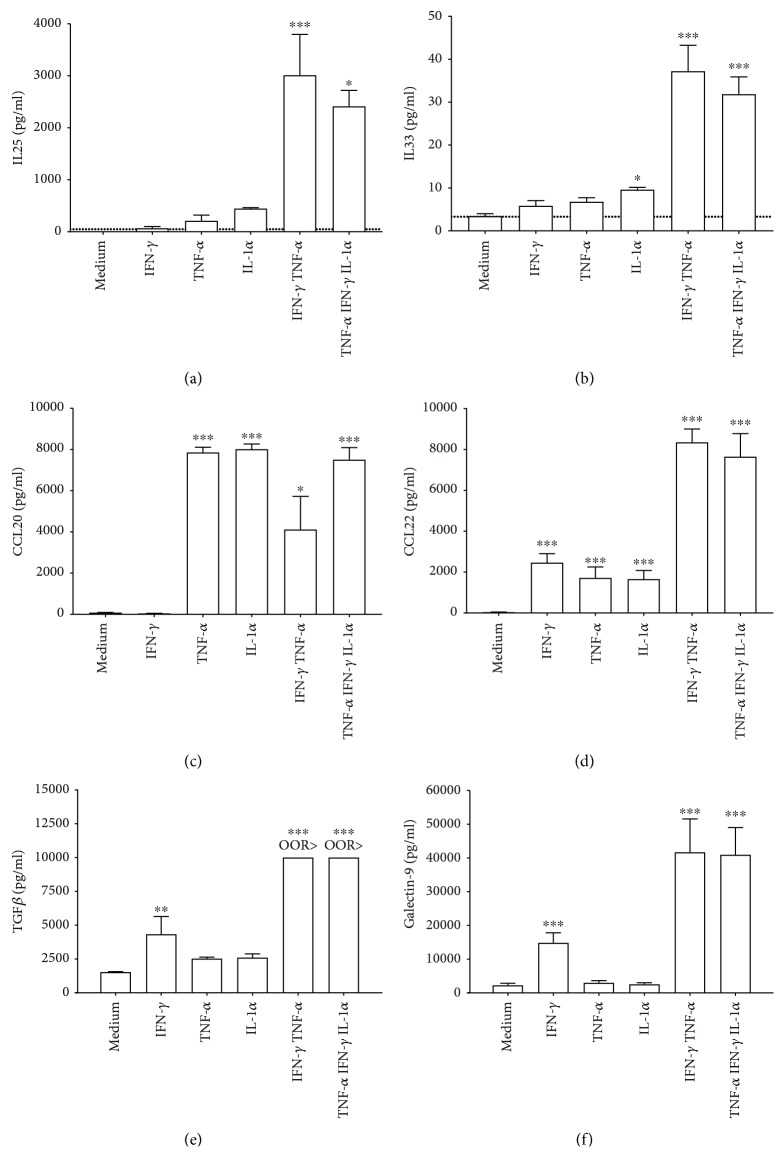
Combined IFNγ and TNFα exposure with or without IL1α enhances the release of Th2-driving cytokines and chemokines by IEC. HT29 cells were cultured in 24-well solid phase plates and preincubated with medium, IFNγ, TNFα, or IL1α (all 10 ng/mL) alone or in combinations for 6 h. Subsequently, the cells were washed and reexposed to medium, after which (a) IL25, (b) IL33, (c) CCL20, (d) CCL22, (e) TGFβ, and (f) galectin-9 were measured in the supernatants after 24 h; N = 3. One-way ANOVA (p value interaction for all mediators <0.01), post hoc test Bonferroni; ∗
p < 0.05; ∗∗∗
p < 0.001. Ticked line represents the limit of detection (LOD), which is the lowest analyte concentration that can reliably be distinguished from the blank value without consideration of precision and accuracy. OOR> = Out-Of-Range above standard curve.